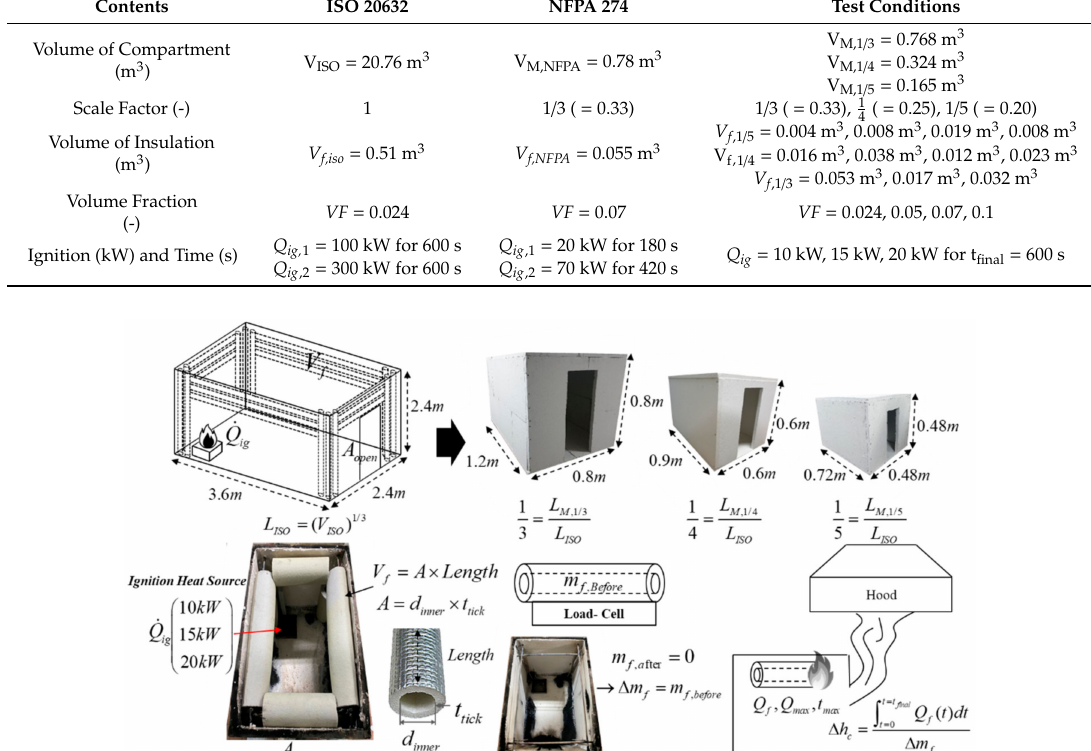
Figure 2. Schematic diagram and pictures of the test conditions and the experiment